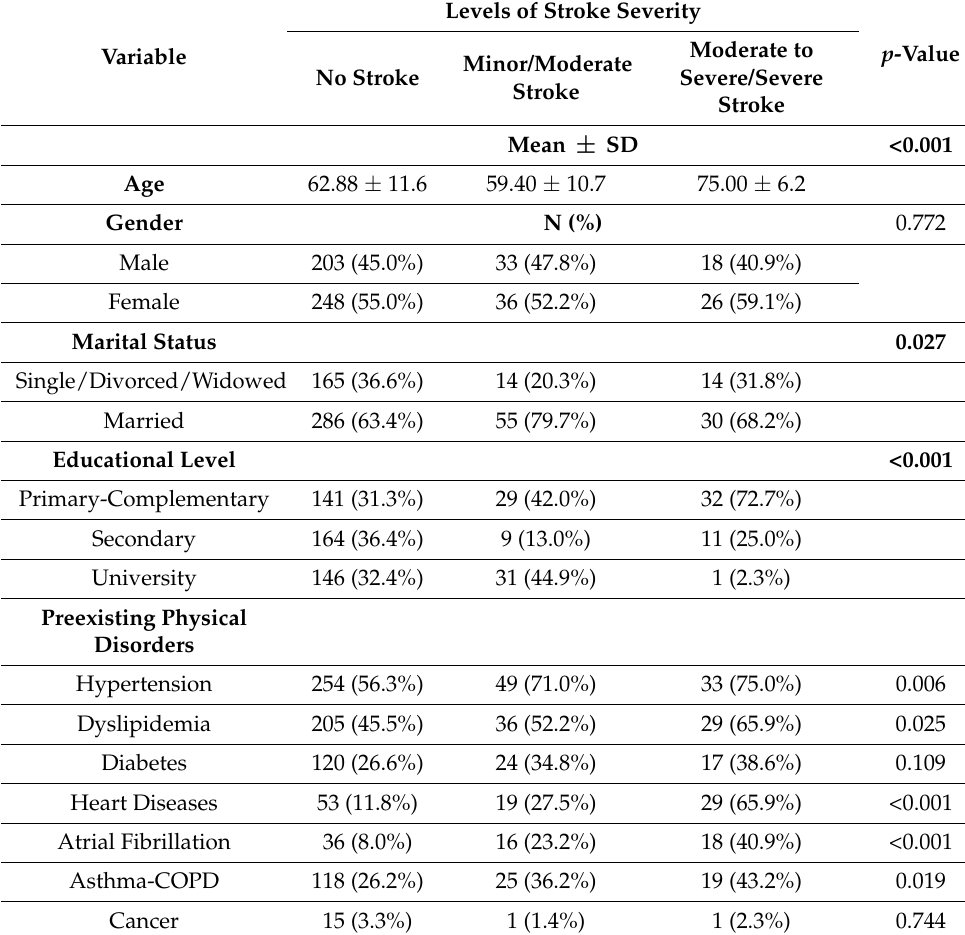
Figure 2. Common risk factors for chronic diseases and mental disorders, as well as their impact on the risk of an ischemic stroke. Figure summarizing the purpose and findings of our research. Table 4. Bivariate analysis of variables associated with the levels of stroke